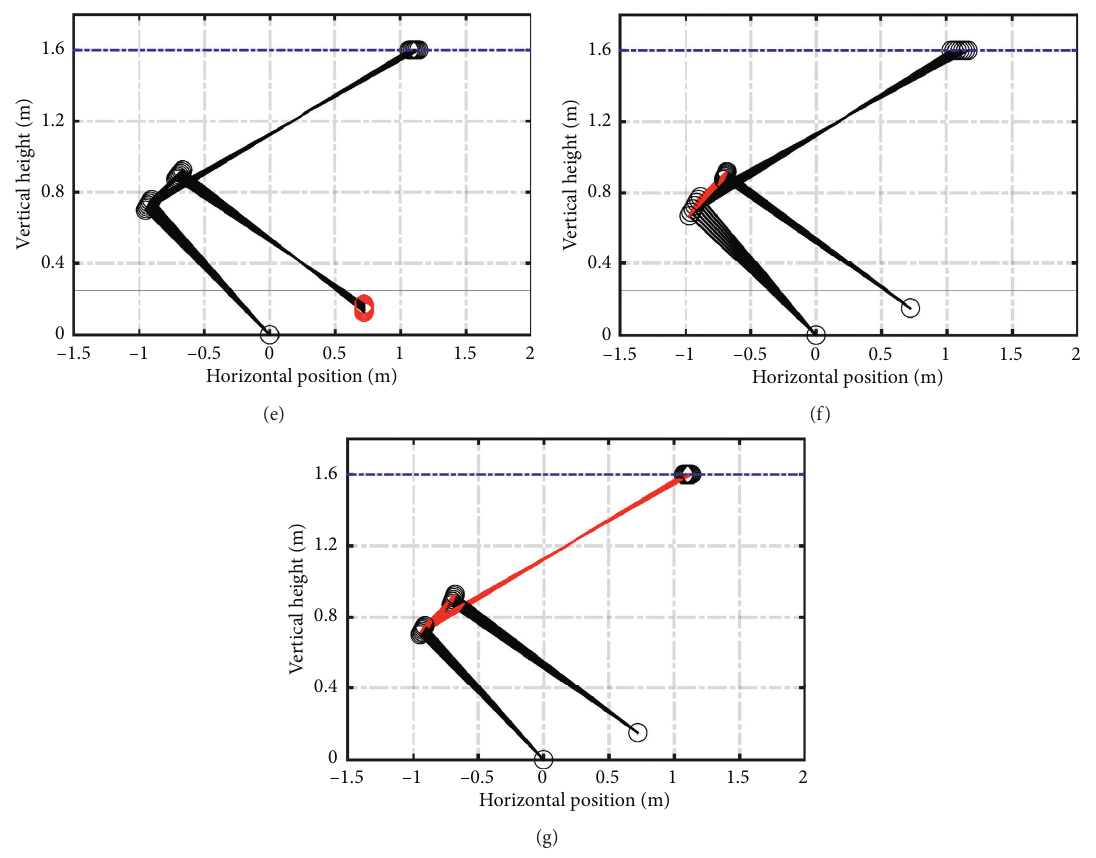
Figure 14: The initial position of the pantograph’s main frame (the red lines or hinges in this figure are the related variable parameters): (a) variation of L 1 (failed at − 15%); . (b) variation of L 2 ; (c) variation of L 4 (failed at 10% and 15%); (d) variation of L a ; (e) variation of L b ; (f) variation of L 5 ; (g) variation of θ 5 (the angles between two red lines).